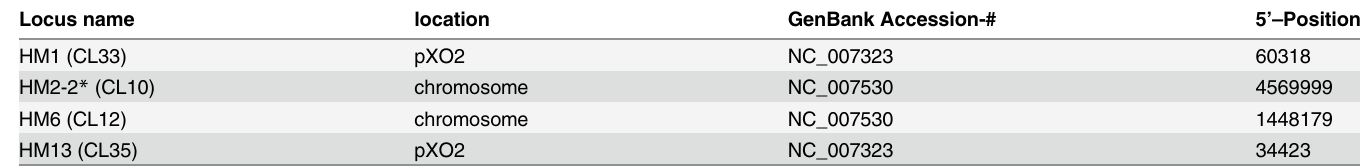
Table 2. SNR loci of B . anthracis analyzed. Information according to [43]. Names of loci in brackets are alternative names [44] of the same